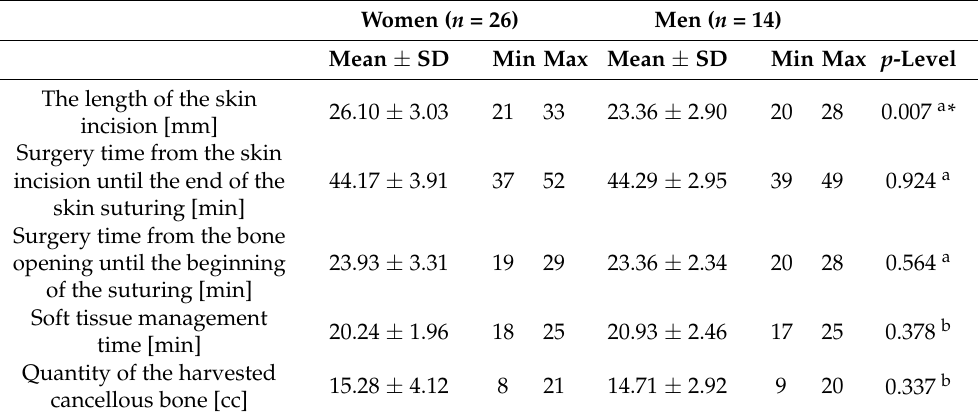
Table 2. Descriptive statistics of selected intraoperative parameters obtained during the procedure of cancellous bone harvesting from the proximal tibia in women and men.